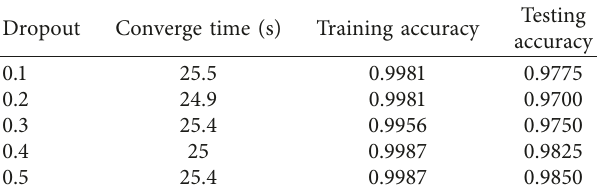
Table 4: Performance of model w.r.t different dropout value.